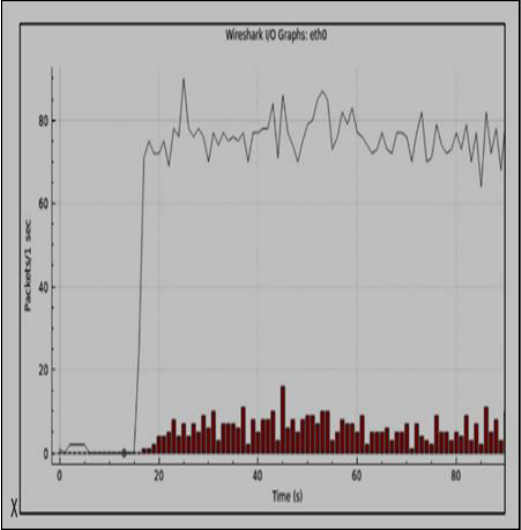
Fig.7 Attacker’s network traffic grap h during the SYN flood attack.